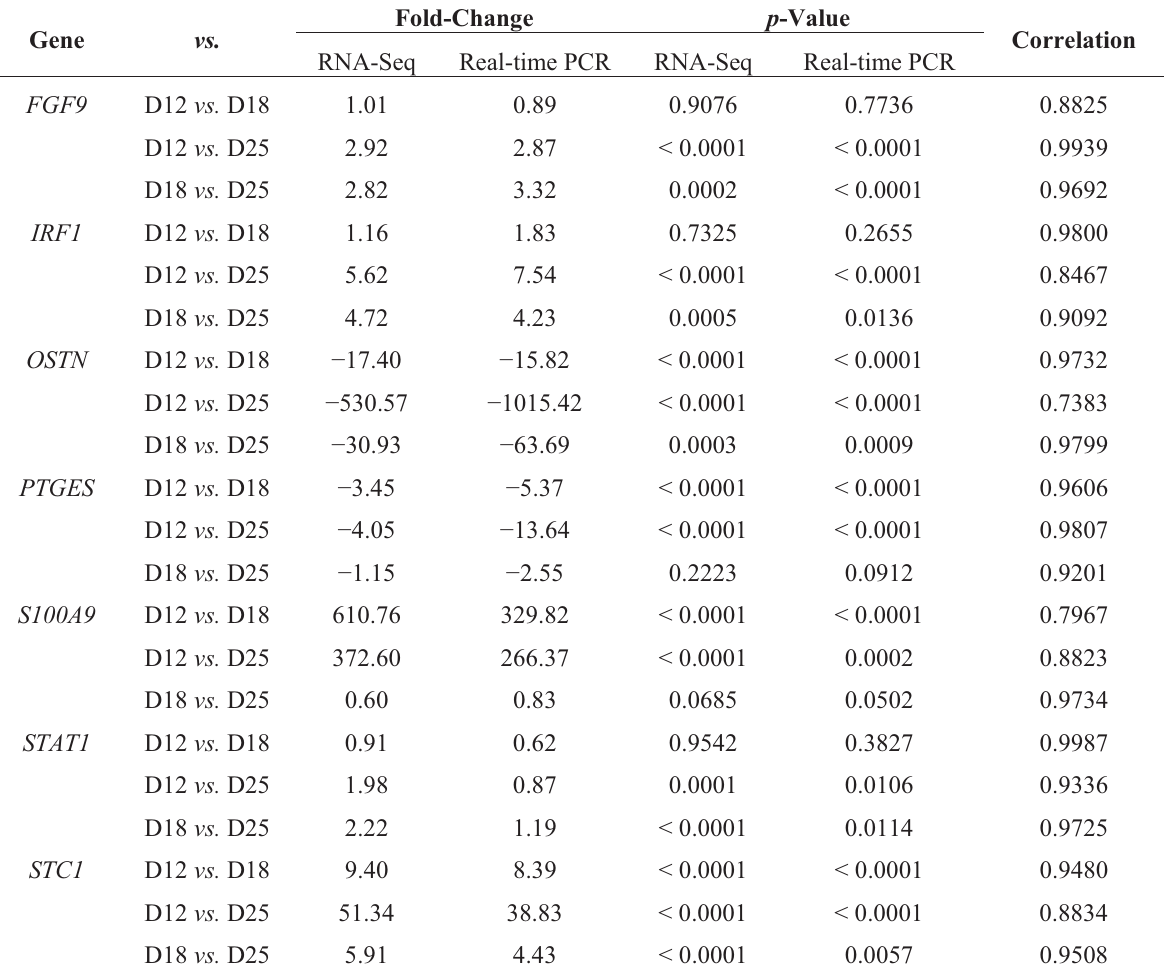
Table 5. Results of selected gene expression validation with quantitative real-time PCR. Fold-Change p Gene vs.